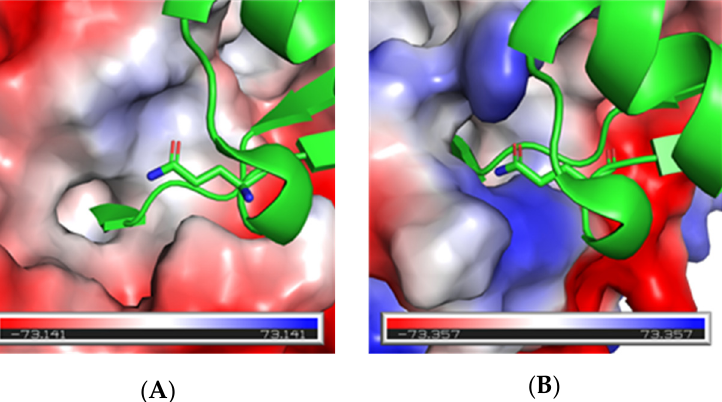
Figure 2. Electrostatic potential surface map representations of Ub (green ribbons) with Q40 (sticks) interaction with UCHL3 ( A ) and UCHL1 ( B ). Electrostatic potential ranges from negative (red) to positive (blue).